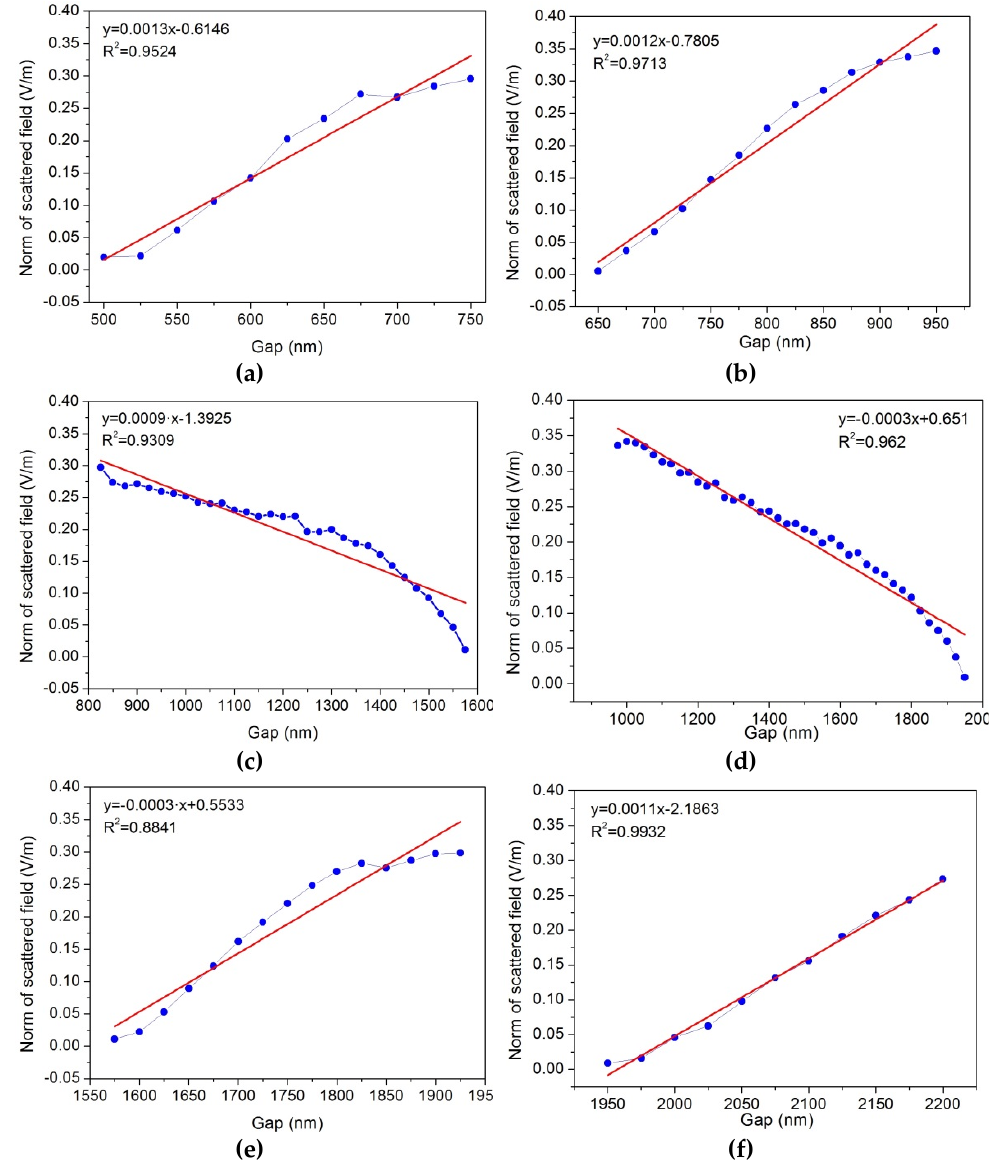
Figure 5. Linear fittings of the norm of the scattered field for 1064 nm. ( a ) Interval I. ( c ) Interval II. ( e ) Interval III. Linear fittings of the norm of the scattered field for 1310 nm. ( b ) Interval I. ( d ) Interval II. ( f ) Interval III .